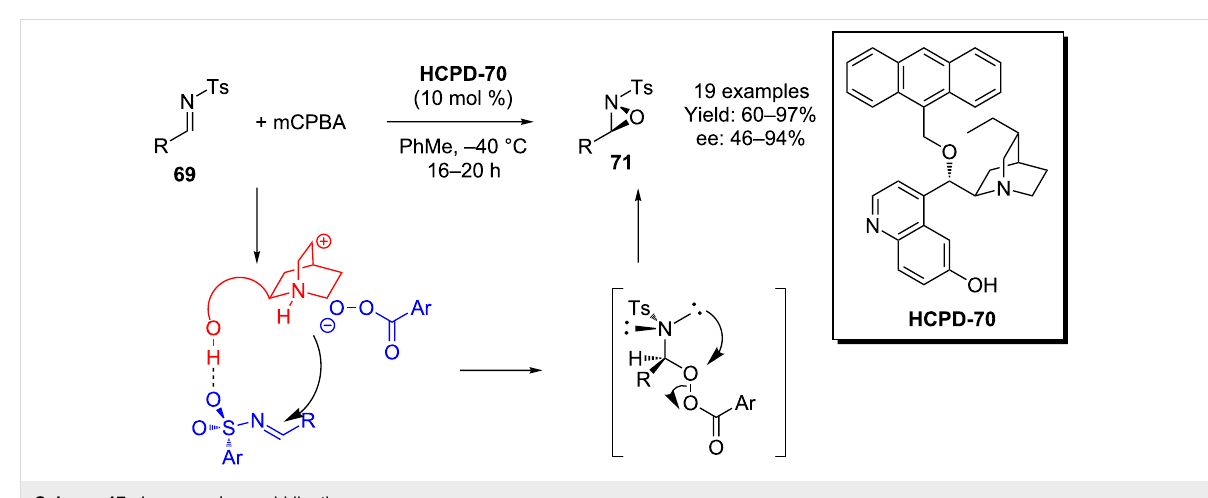
Scheme 17: Jørgensen’s oxaziridination.